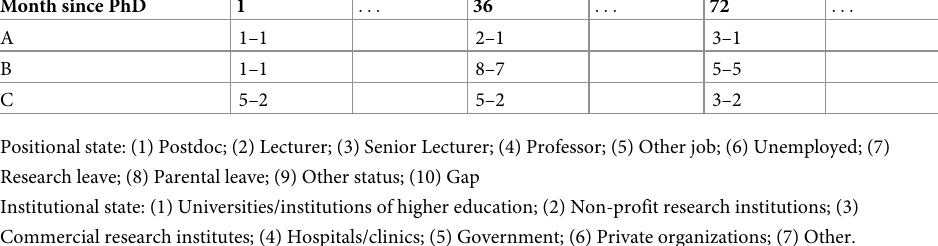
Table 1. Research career sequences, defined by positional state (first digit) and institutional state (second digit), for selected months since PhD–three illustrations. Month since PhD 1 ... 36